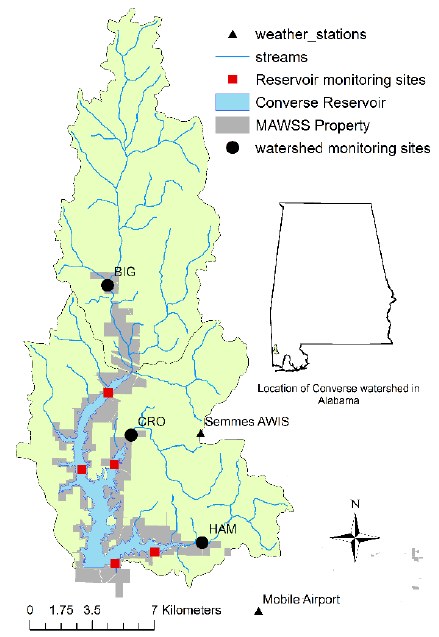
Figure 1. Monitoring locations, weather stations, and Mobile Area Water and Sewer System (MAWSS) property in the Converse watershed and reservoir located in southwestern